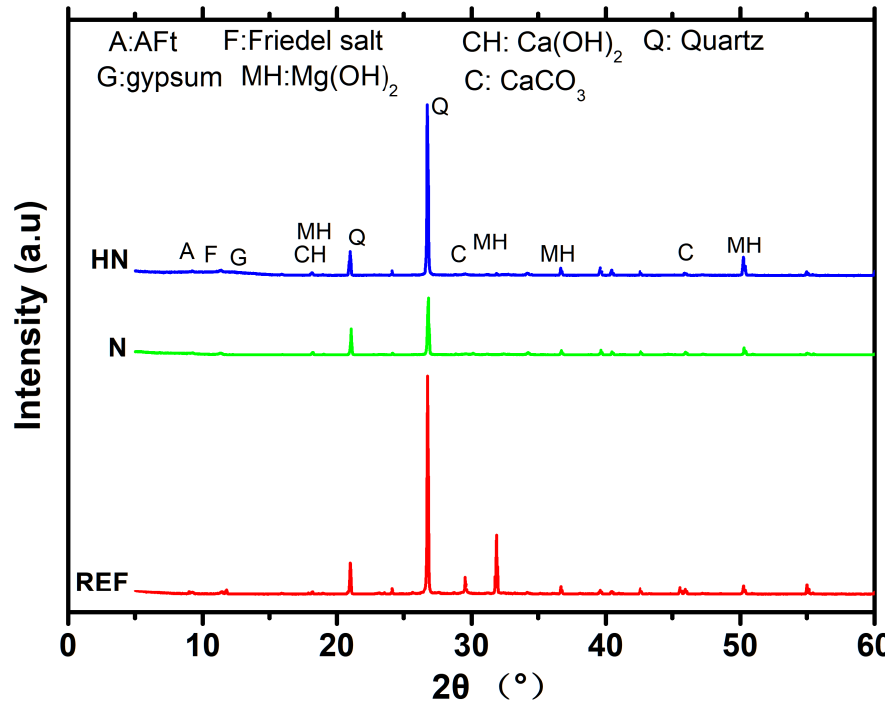
Figure 3. XRD patterns of specimen exposed to seawater for 28 d.